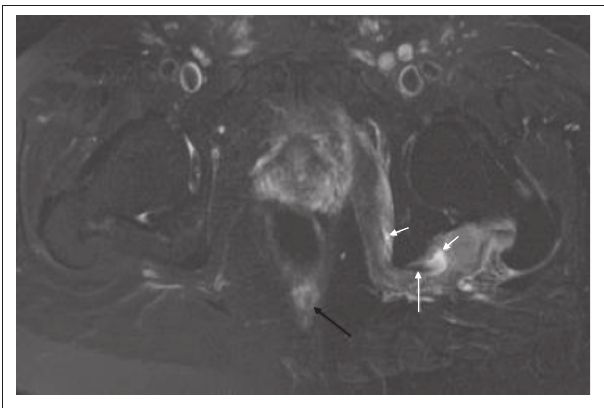
FIGURE 5: Axial T2FS of the pelvis. Fluid in the obturator internus bursa with a ‘boomerang’ configuration around the iliac spine (short white arrows). The obturator internus tendon (long white arrow) and pre-coccygeal signal (long black arrow) are also shown.